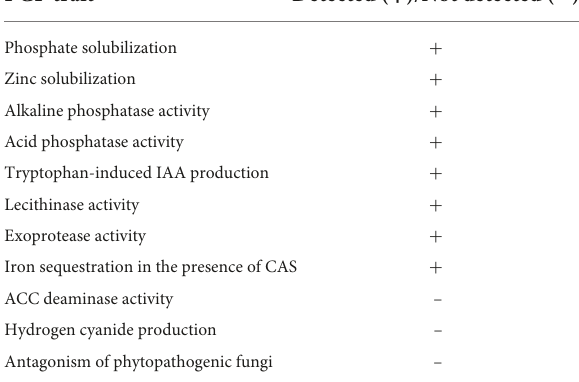
TABLE 1 In vitro plant growth-promoting traits of Pseudomonas sp. strain